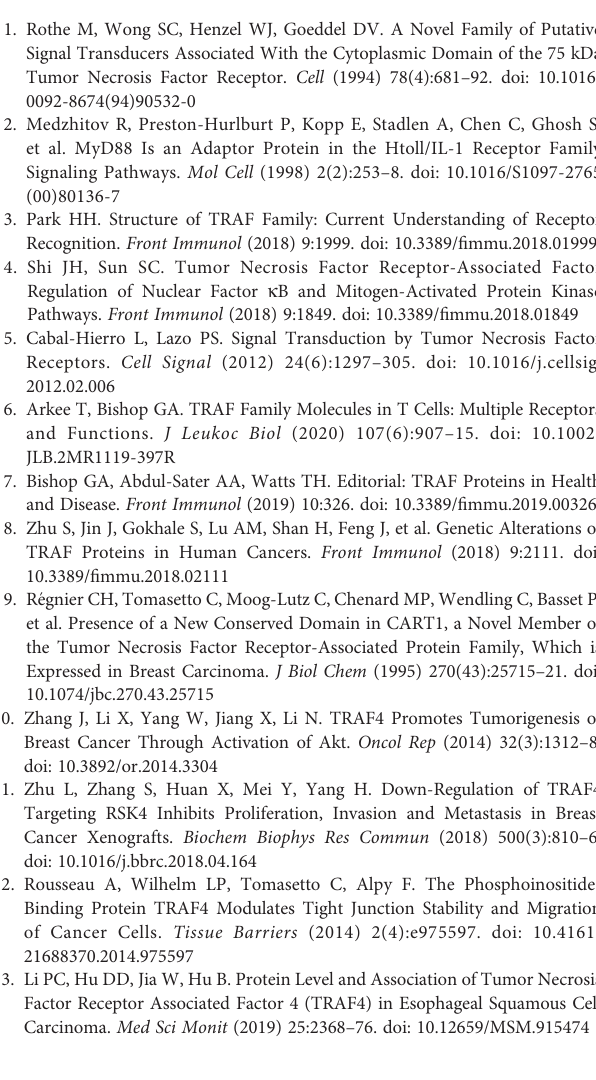
Supplementary Figure 1 | Protein level of Eg5. Proteins were extracted from cells transfected with Eg5 si-RNA.Western blot assays were used to demonstrate the protein level of Eg5. GAPDH was used as an internal control. Data represent mean ± SD ( n = 3). (***p<0.001). Supplementary Figure 2 | Protein level of TRAF4, Eg5 and Smurf2 in non- malignant breast epithelial cell line MCF-10A and breast cancer cell lines MDA-MB- 231, SK-BR-3, MCF-7 and MDA-MB-453, as analyzed by western blot. GAPDH was used as an internal control. Data represent mean ± SD ( n = 3). (* p < 0.05, **p<0.01, ***p<0.001). Supplementary Figure 3 | Co-immunoprecipitation assays were performed on MCF-7 cell lysates using antibodies against TRAF4, Eg5 or Smurf2, followed by